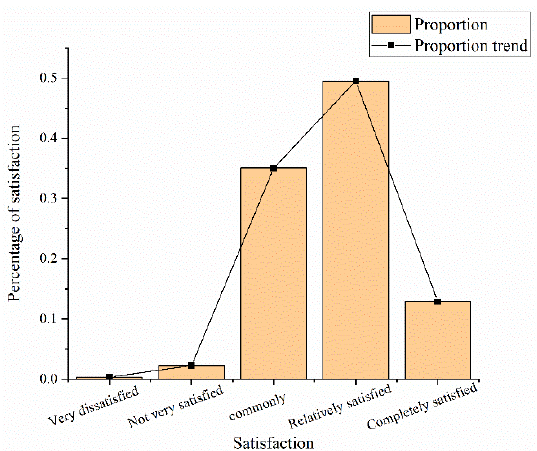
Figure 10. Survey respondents’ overall evaluation of the dissemination strategy of the urban tourism image based on big data analysis technology (drawn according to the test results after research and design combined with